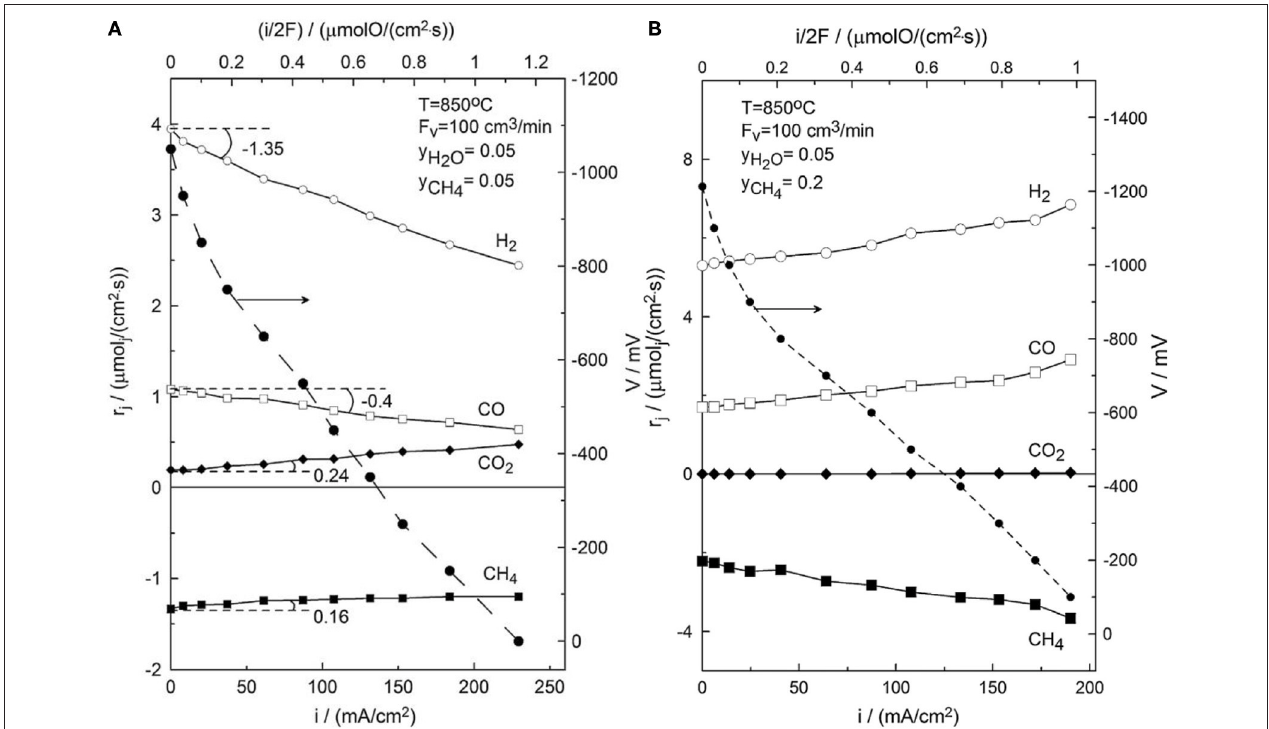
/ y CH , T = 850 ◦ C, 1 wt.% Au-Ni/GDC 2 O 4